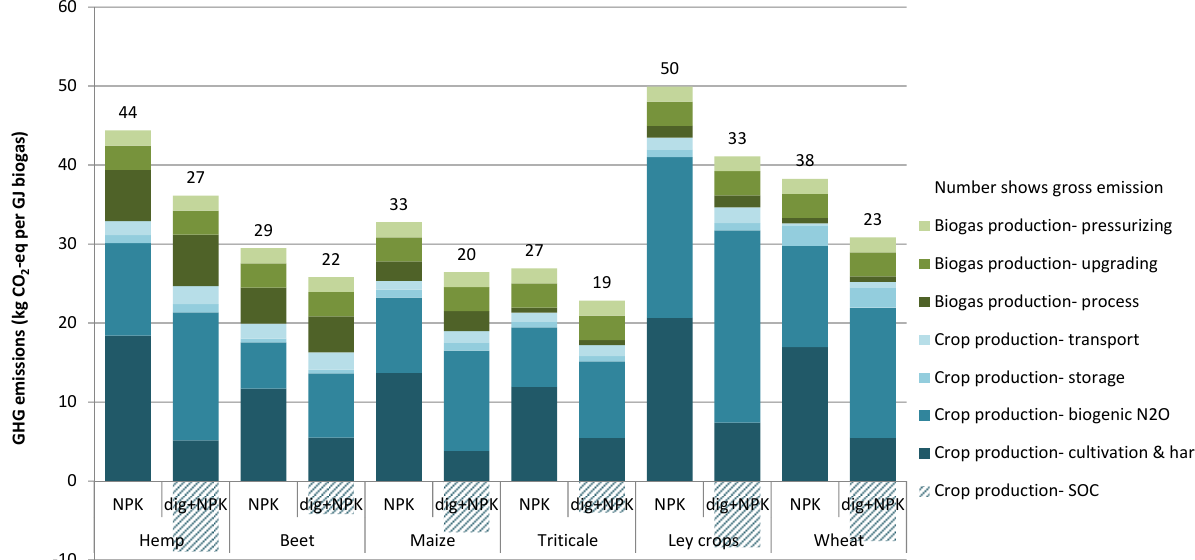
Figure 5. GHG performance of the various crop-based biogas production systems (expressed as kg CO 2 -eq·GJ − 1 biogas) for the two alternative cultivation systems; including only mineral fertiliser (NPK) and digestate complemented with mineral fertiliser (dig+NPK), respectively. The credit of increased SOC content from the digestate (dig+NPK) is shown as negative bars and the numbers above the bars show the net GHG performance including this credit. According to the GHG calculation methodology in EU RED